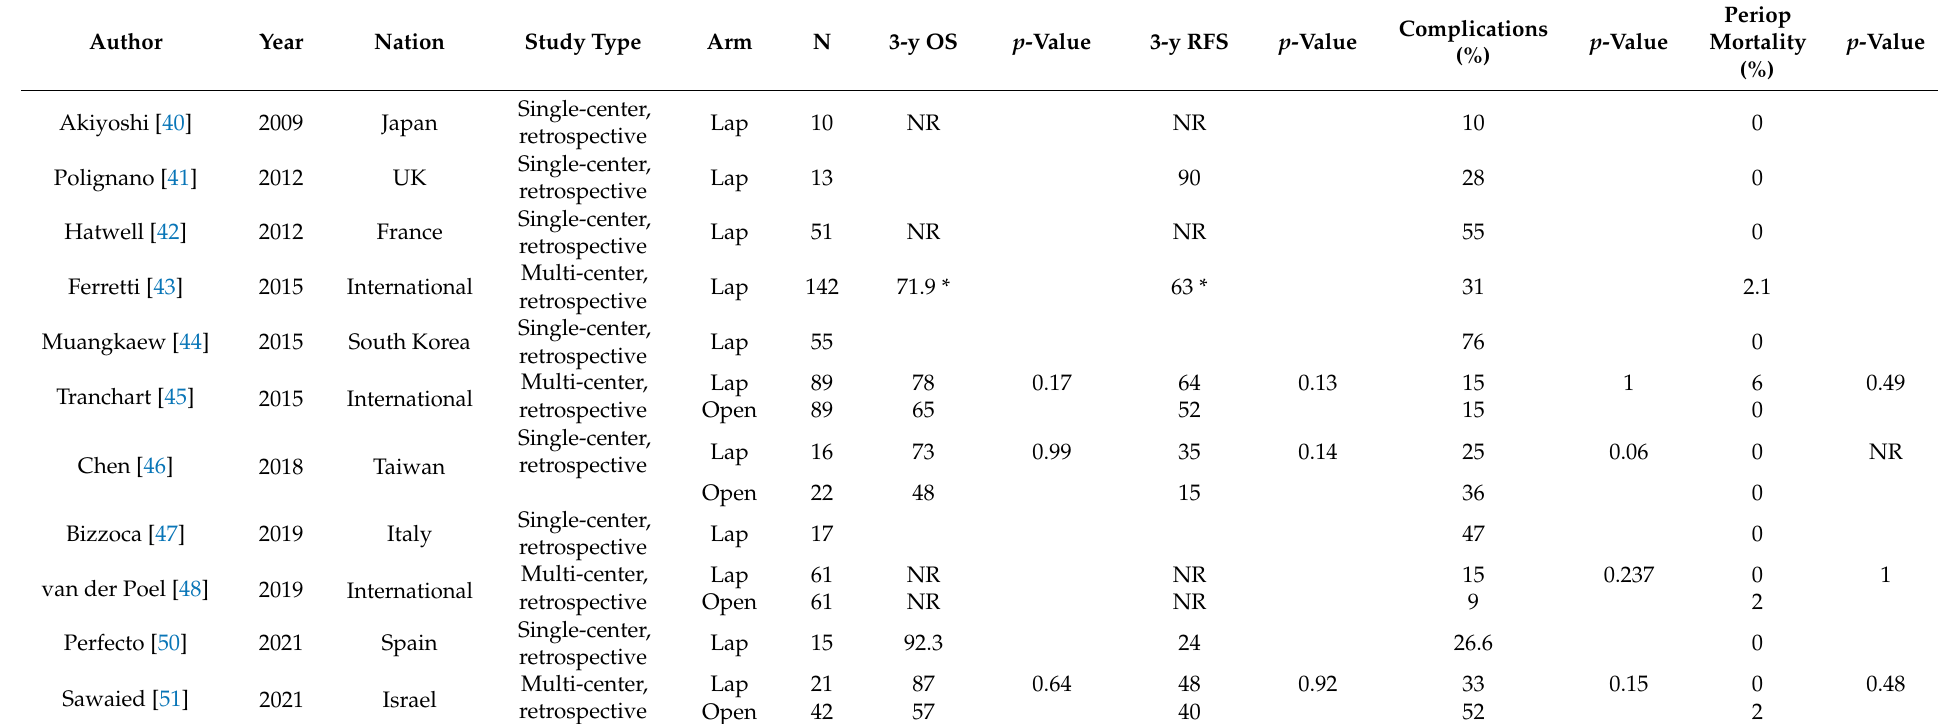
Table 4. Studies evaluating synchronous resections of colon primary and metastatic liver